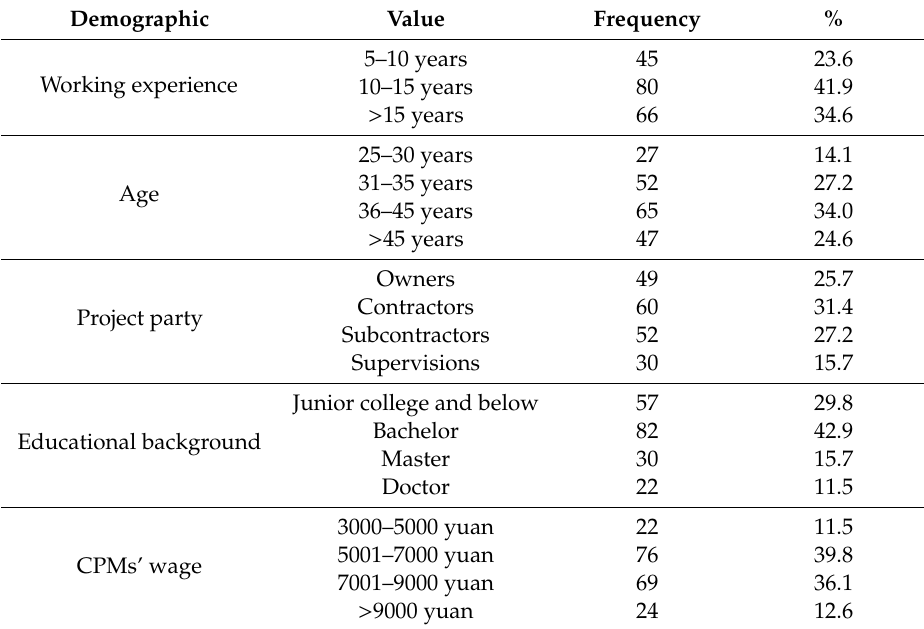
Table 2. Demographic characteristics of the sample (N =